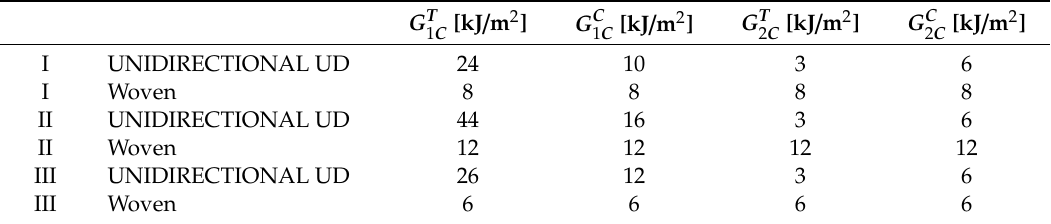
Table 6. Fracture toughness